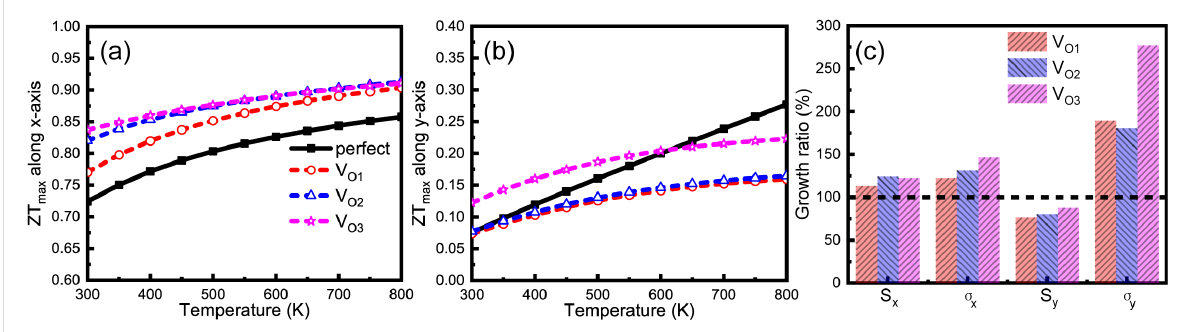
Figure 3: The maximum ZT values as a function of temperature along (a) the x -axis and (b) the y -axis. (c) The growth ratio of the Seebeck coefficient and the electrical conductivity along the x -axis and the y -axis at room temperature.